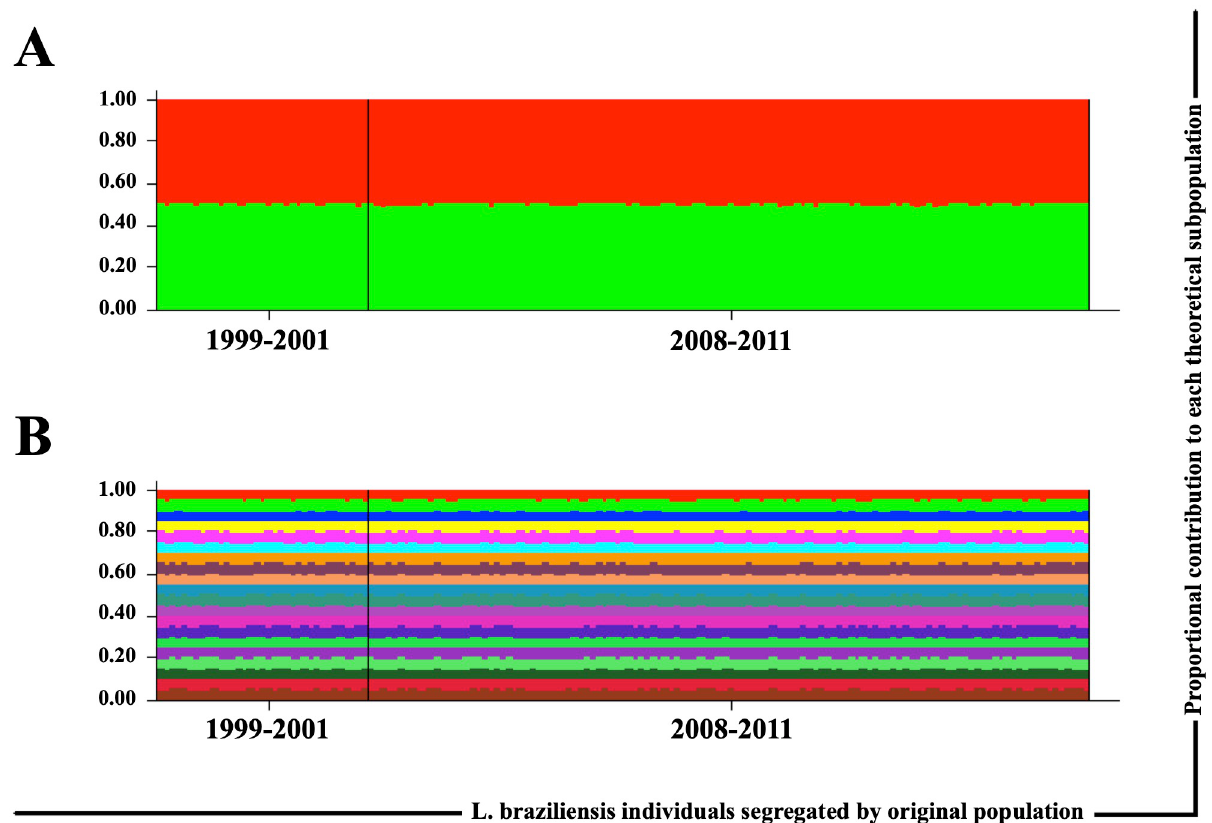
Fig 5. L . braziliensis individuals contribute similarly to putative subpopulations predicted by Structure, based on their genotypes in CHR24/3074 and CHR28/425451 loci , in Corte de Pedra. Structuralization within Corte de Pedra’s L . braziliensis population into discrete subpopulations was assessed using the software STRUCTURE [21]. The analyses were performed using combined data of CHR24/3074 and CHR28/425451 loci . Two conditions were tested: (A) structuralization into two subpopulations, i.e. K = 2; and (B) structuralization into 20 subpopulations, i.e. K = 20. Histograms show the proportional contributions of each individual in the overall sample to each theoretical subpopulation ordered by sampling period (i.e. 1999–2001 and 2008–2011) after a burn-in step of 10,000 runs followed by 100,000 MCMC replications of the data.